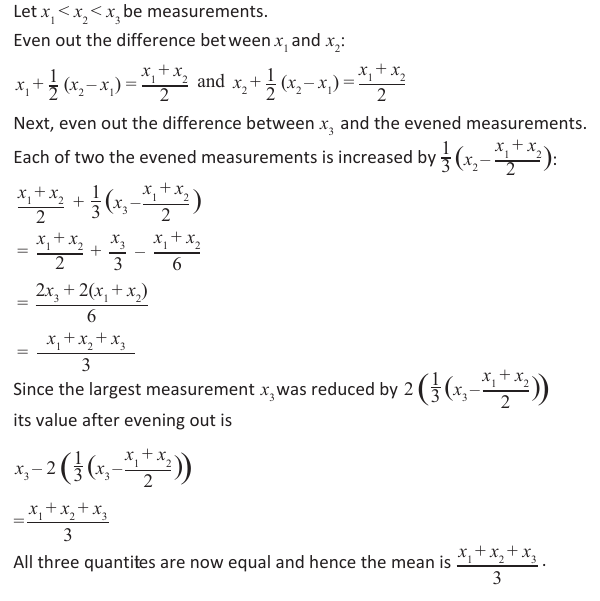
FIGURE 5: Algebraic derivation of the algorithm for the statistical mean.